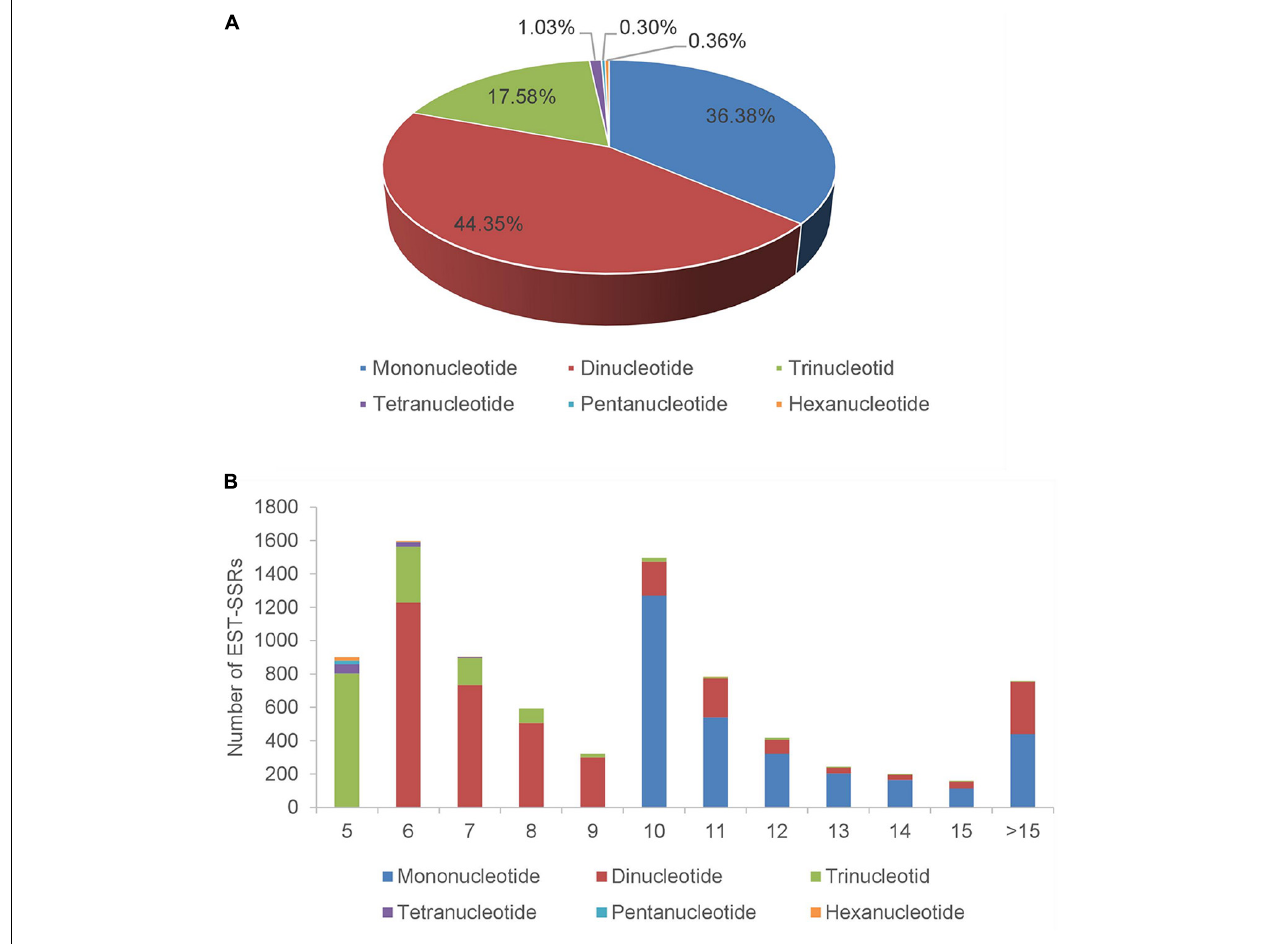
FIGURE 2 | The distribution of SSRs in transcriptome of A. biserrata . (A) Percentage of different SSRs types in total SSRs. (B) The number of SSRs types under different repetition times. X -axis represents the times of repetition, and Y -axis represents the number of SSRs.